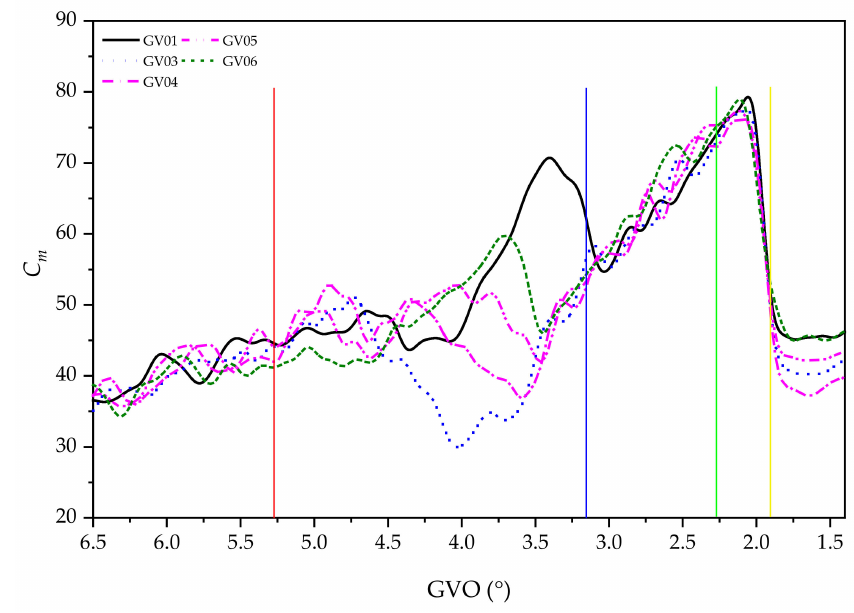
Figure 16. GVO- C m plot of the shutdown